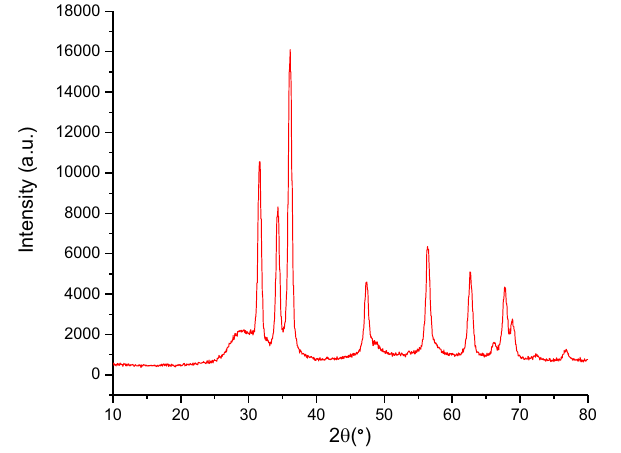
Figure 2. XRD pattern of nanoporous Zn-MOF microspheres.